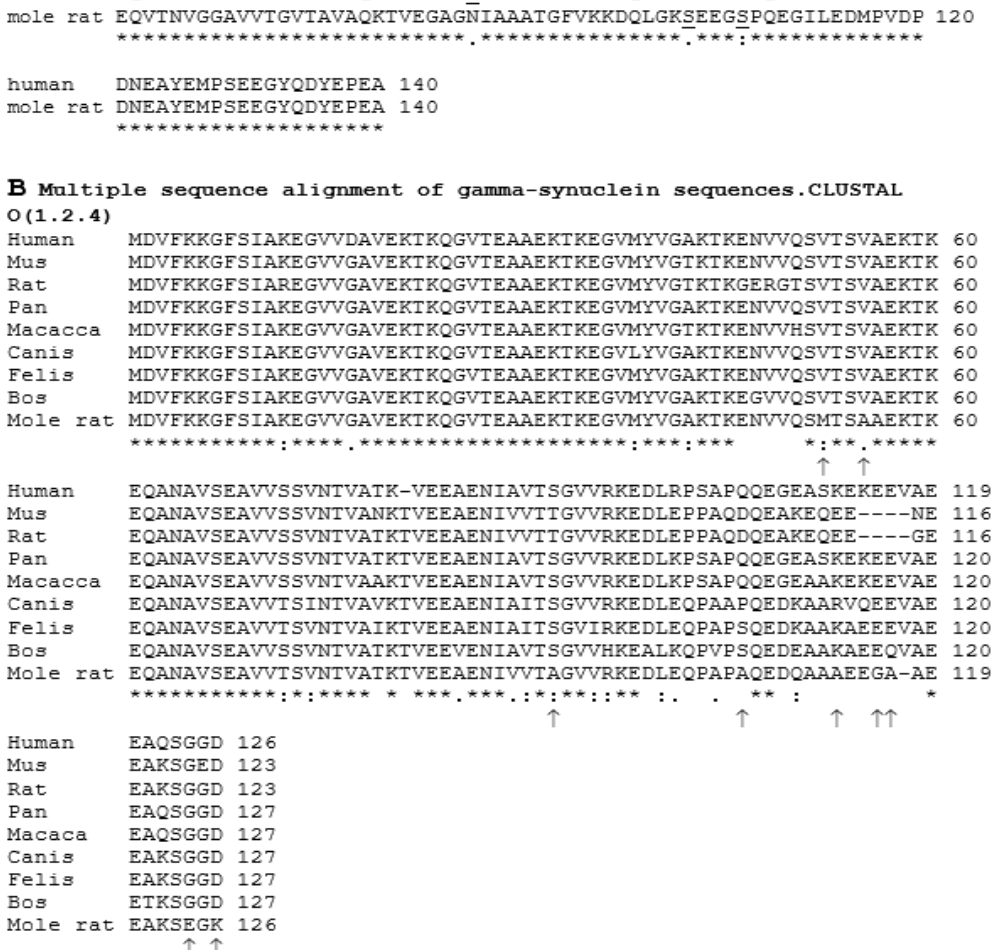
Figure 6. Alignment of amino acid sequences of synucleins. ( A ) N-termini of α -synuclein from a human and naked mole rat have high similarity in amino acid sequences. However, the localization of critical serine residues in the central part of the protein molecule is di ff erent. Phosphorylation of Serine 87 in the human protein regulates α -synuclein oligomerization, changes amyloidogenic properties of the protein and influences synuclein-membrane interactions [56]. On the other hand, serine residues in positions 103 and 107 of α -synuclein from naked mole rat are located in the region which participates in the long-range interactions with the hydrophobic NAC region (amino acids 61–95) determining the ability of α -synuclein to aggregate and form amyloids [57]. ( B ) Alignment of γ -synuclein amino acid sequences from vertebrates. N-termini have very conservative sequences, whereas C-termini are more variable. γ -Synuclein from naked mole rat contained nine unique amino acids, including five alanine residues located predominantly in the C-terminus of the protein. Arrows at the bottom show unique amino acids in the naked mole rat protein. The alignment was performed using CLUSTAL